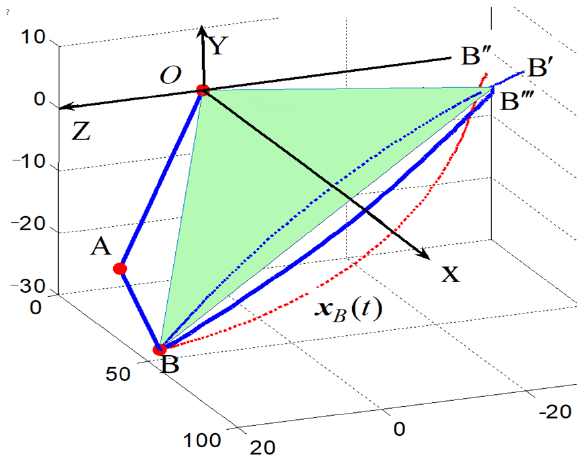
Figure 17. Endpoint trajectories under the controllers.